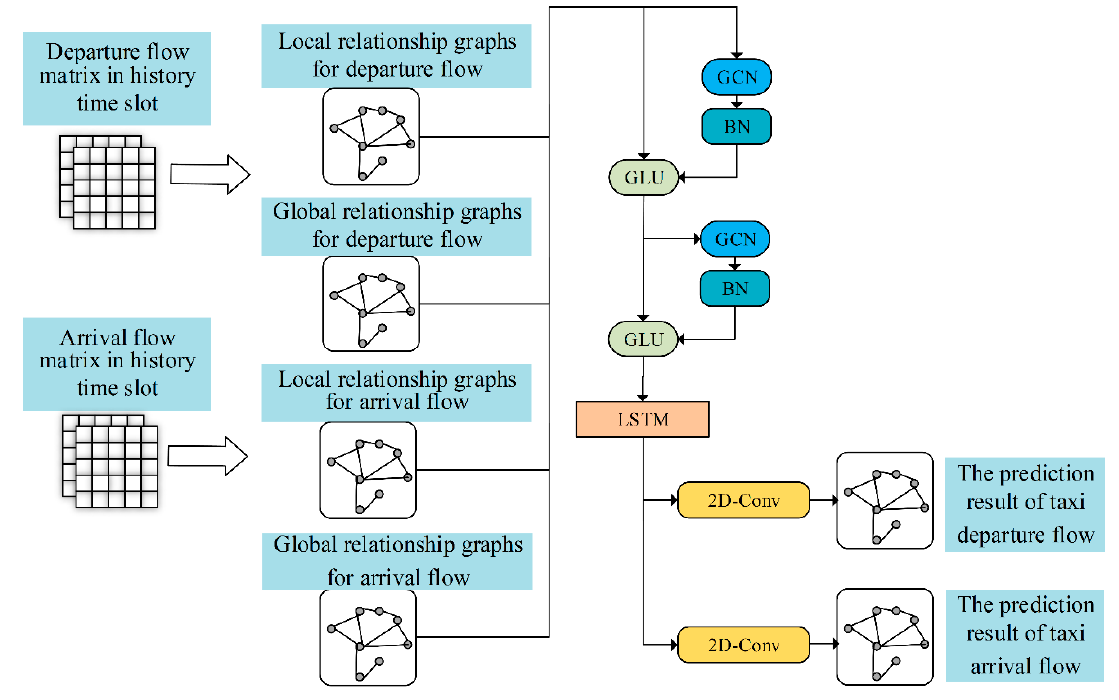
Figure 4. Multitask GCN-LSTM (MGLN) network.